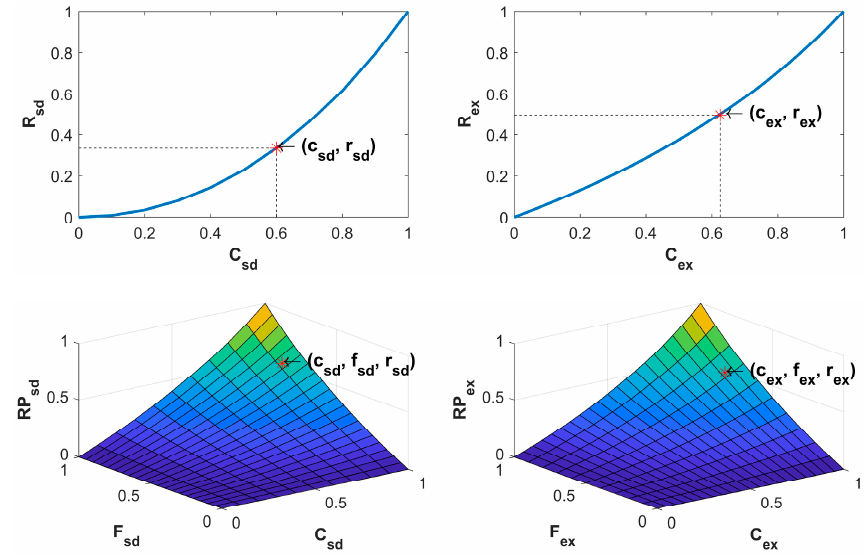
Figure 2. Typical characteristics of R sd ( C sd ) in Equation (7), R ex ( C ex ) in Equation (8), RP sd ( C sd , F sd ) Figure 2. Typical characteristics of (cid:1844) (cid:3046)(cid:3031) ( (cid:1829) (cid:3046)(cid:3031) ) in Equation (7), (cid:1844) (cid:3032)(cid:3051) ( (cid:1829) (cid:3032)(cid:3051) ) in Equation (8), in Equation (9), RP ex ( C ex , F ex ) in Equation (10) are shown in top left, top right, bottom left, and bottom (cid:1844)(cid:1842) (cid:3046)(cid:3031) ( (cid:1829) (cid:3046)(cid:3031) , (cid:1832) (cid:3046)(cid:3031) ) in Equation (9), (cid:1844)(cid:1842) (cid:3032)(cid:3051) ( (cid:1829) (cid:3032)(cid:3051) ,(cid:1832) (cid:3032)(cid:3051) ) in Equation (10) are shown in top left, top right, right respectively. C sd , C ex , F sd , and F ex are sets of possible values of c sd , c ex , f sd , and f ex , bottom left, and bottom right respectively. (cid:1829) (cid:3046)(cid:3031) , (cid:1829) (cid:3032)(cid:3051) , (cid:1832) (cid:3046)(cid:3031) , and (cid:1832) (cid:3032)(cid:3051) are sets of possible values of (cid:1855) (cid:3046)(cid:3031) , (cid:1855) (cid:3032)(cid:3051) , (cid:1858) (cid:3046)(cid:3031) , and (cid:1858) (cid:3032)(cid:3051) , respectively.